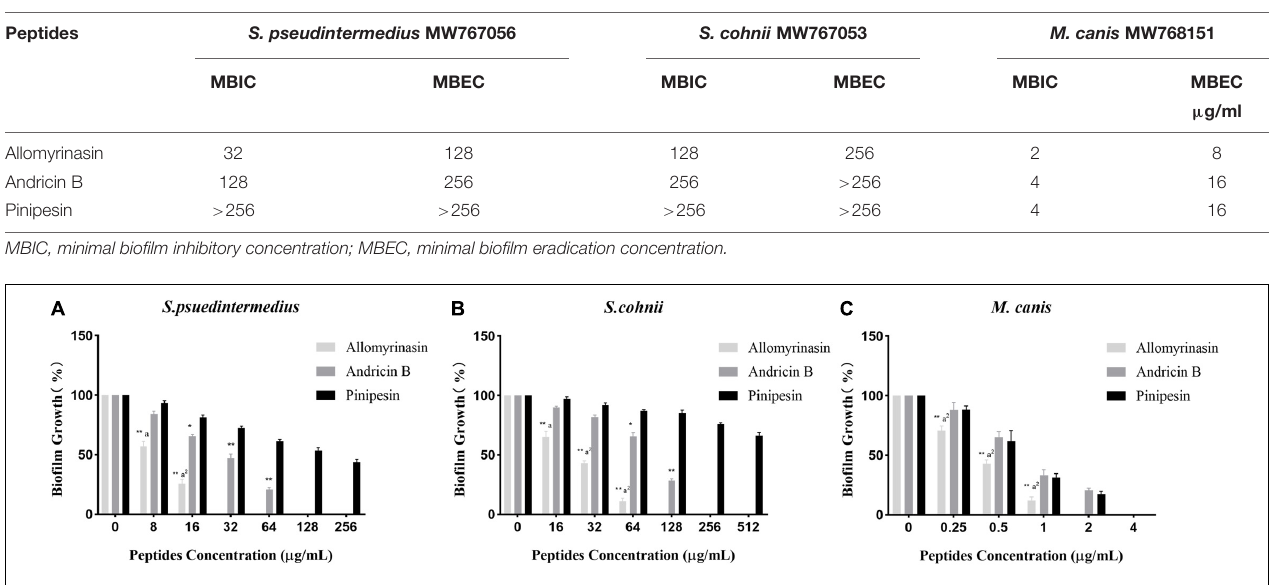
FIGURE 3 | Effect of antimicrobial peptides on biofilm formation rate of Staphylococcus pseudintermedius MW767056 (A) , Staphylococcus cohnii MW767053 (B) , and Microsporum canis MW768151 (C) . All data are shown as the mean ± SD from the experiment performed in triplicate. * p < 0.05, ** p < 0.01 significant difference between pinipesin and the other two peptides; a p < 0.05, a2 p < 0.01 significant difference between allomyrinasin and andricin